Question: Draft a figure caption describing what is shown.
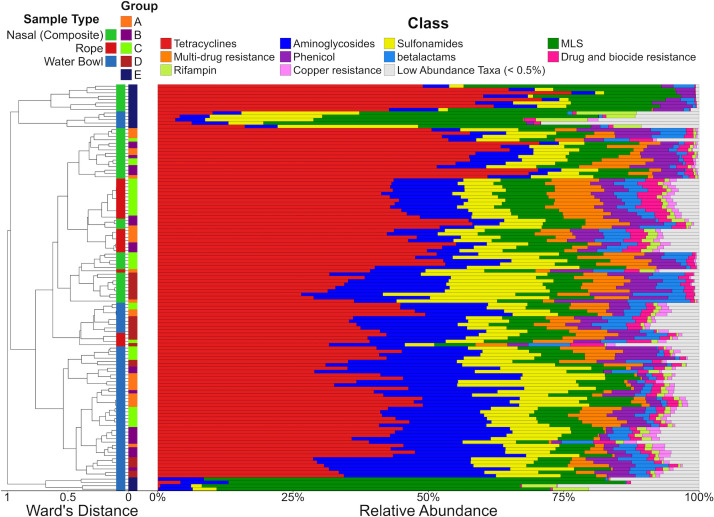
Answer: Relative abundance and clustering of the sample resistomes across sample types and cattle groups as estimated through target-enriched shotgun sequencing. Hierarchical clustering was based on Bray-Curtis distances for samples’ resistome composition at the level of ARG groups, and their associated resistome composition (relative abundance) is shown at the level of ARG classes. Each bar represents a sample, which is annotated by sample type (nasal swab composite, rope, or water bowl) and cattle group (A–E). The 10 most abundant ARG classes are listed in the legend, and low abundance taxa were ARG classes with a median abundance value of less than 0.5% across all samples.